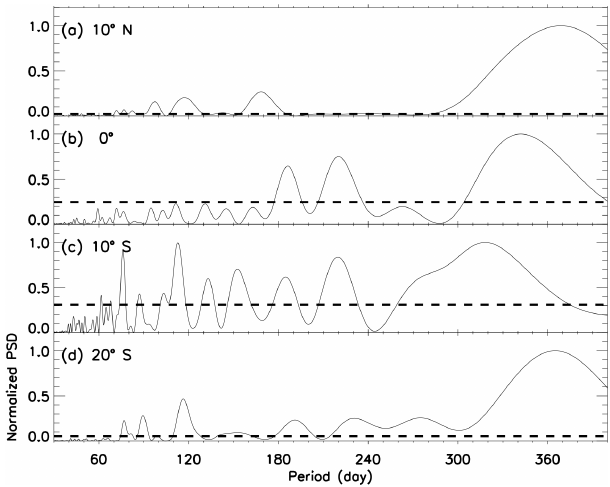
Figure 3. Lomb–Scargle periodogram for (a) 10 ◦ N, (b) 0 ◦ , (c) 10 ◦ S and (d) 20 ◦ S. The horizontal dashed lines represent the confidence level of 99%, i.e., false alarm probability of